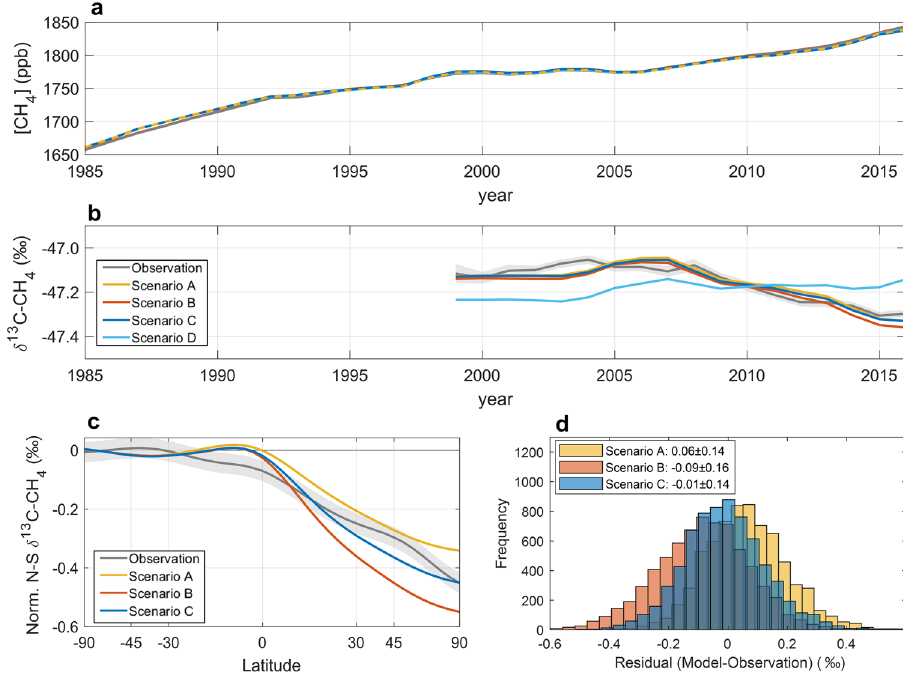
Fig. 4 Observed and simulated atmospheric CH 4 and δ 13 C-CH 4 from TM5 atmospheric modeling. a , b Model-data comparison of long-term trend of ( a ) atmospheric CH 4 from 1985 to 2016 (in ppb) and ( b ) δ 13 C-CH 4 from 1999 to 2016 (in ‰ ) by observation (gray) and simulations from Scenario A (yellow), B (red), C (blue), and D (skyblue). c Model-data comparison of normalized north – south gradient of atmospheric δ 13 C-CH 4 for Scenario A (yellow), B (red), and C (blue) in 2012. The north – south δ 13 C-CH 4 was calculated by zonally-averaging the surface δ 13 C-CH 4 and normalized based on the mean δ 13 C-CH 4 at 60 – 90 °S. The normalized north – south δ 13 C-CH 4 for other years is in Supplementary Fig. 20 and Supplementary Table 9. d Histogram of the difference between simulated and observed δ 13 C-CH 4 for Scenario A (yellow), B (red), and C (blue) for 6 measurement sites located in the northern hemisphere. The histogram plots for all measurement sites are in Supplementary Fig. 22. Information about Scenarios A – D is in Table